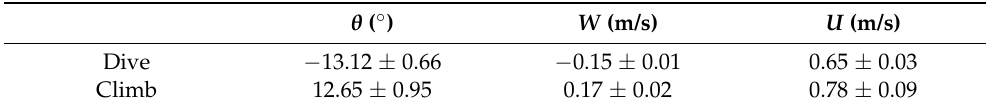
Table 1. Typical average and standard deviation of pitch angle ( θ ), vertical speed ( W ) , and speed along the turbulence AUV path ( U ).